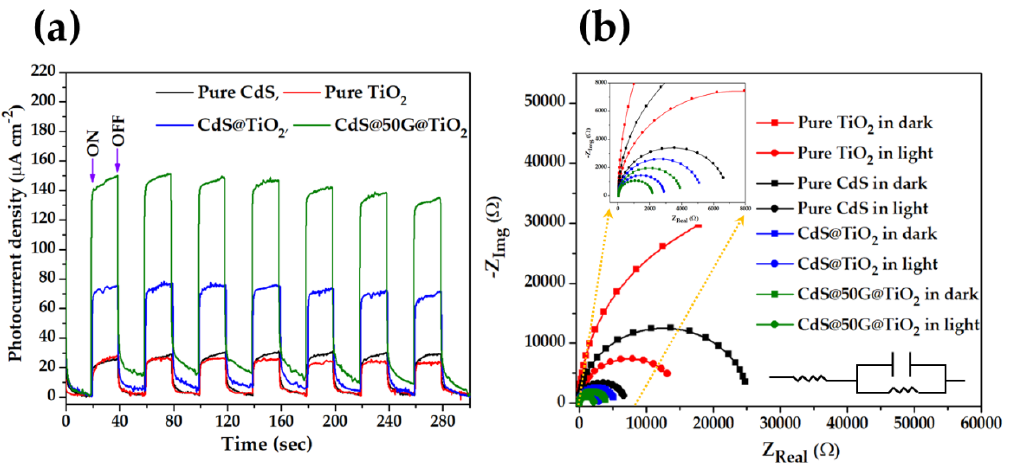
Figure 5. Transient photocurrent response ( a ) and EIS Nyquist plots ( b ) of pure TiO 2 , pure CdS, CdS@TiO 2 and CdS@50G@TiO 2 in light and dark.